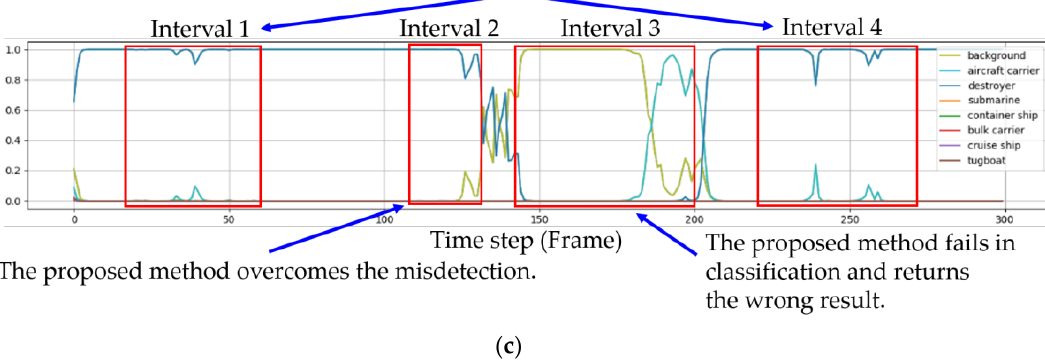
Figure 8. The change in the confidences in the image sequence with environmental factors: ( a ) Faster R-CNN, ( b ) Faster R-CNN and IoU tracking, and ( c ) Faster R-CNN, IoU tracking and Bayesian fusion.